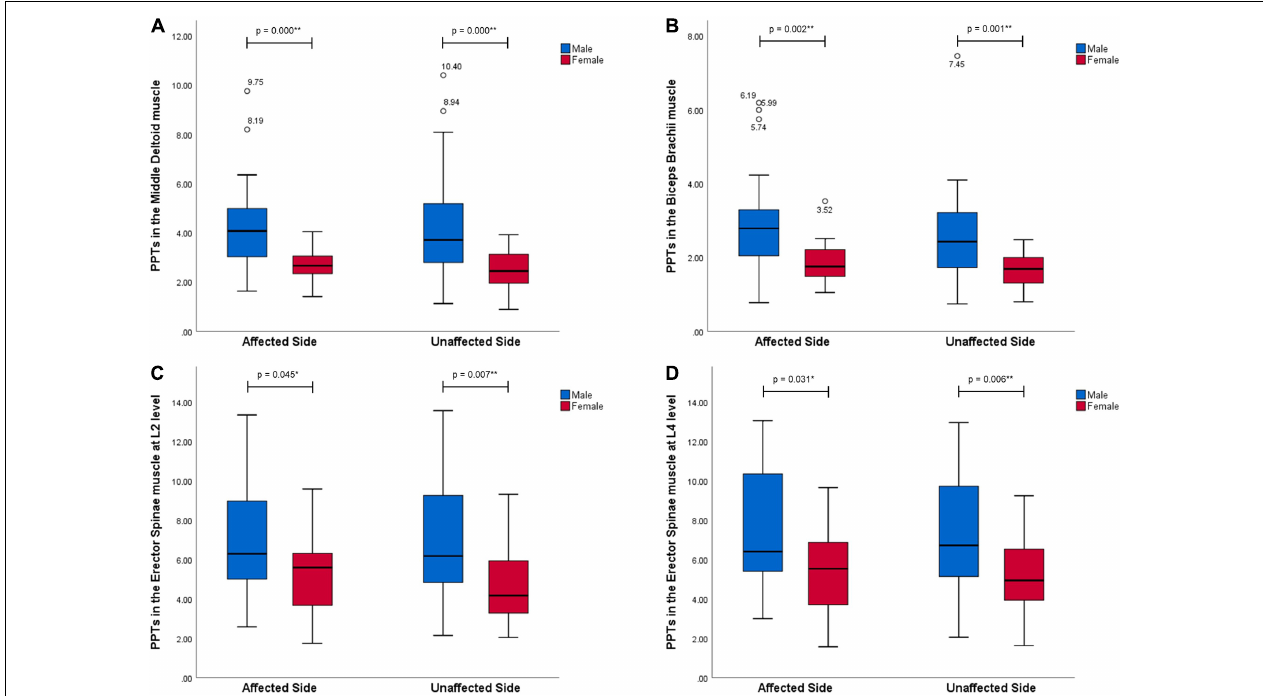
FIGURE 1 | Gender differences in PPT values in the muscles in the upper extremities and trunk (kgf). All muscles, MD (A) , BB (B) , and L2 (C) , L4 (D) levels of ES, at both sides performed significantly higher pressure pain thresholds in men than women with stroke ( p < 0.05). * Representing a statistically significant difference with p < 0.05; ** representing a statistically significant difference with p <